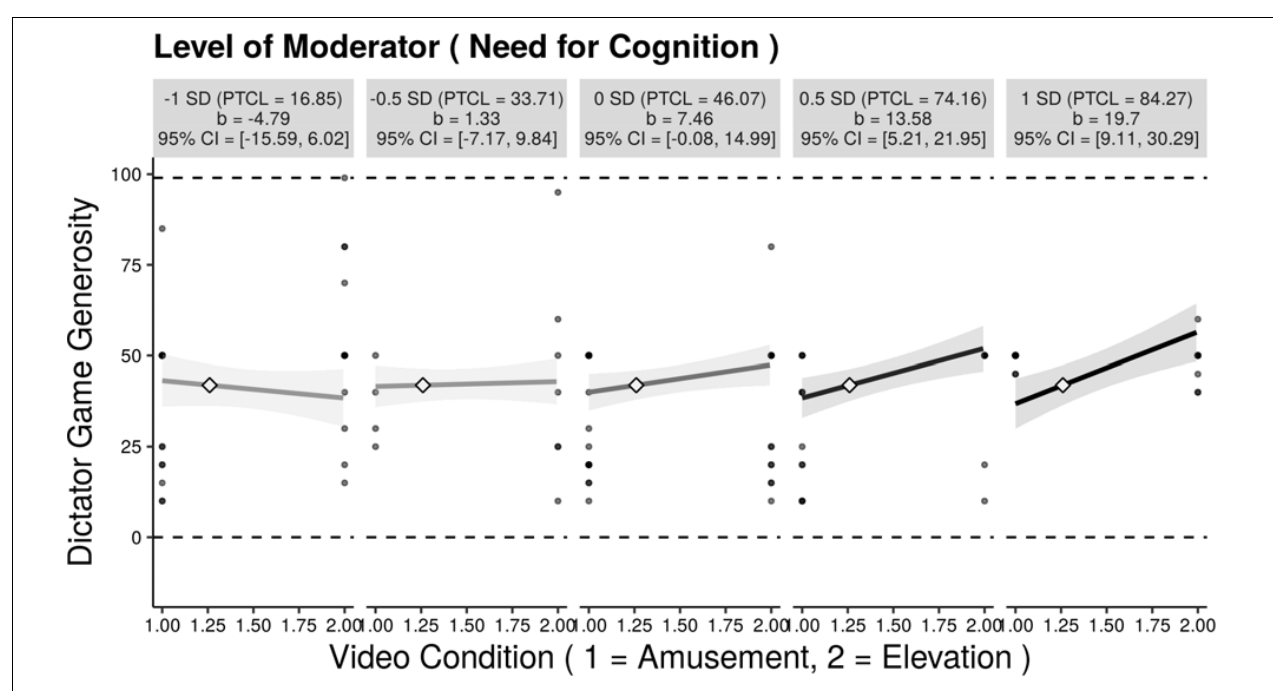
FIGURE 5 | Small-multiples depictions of the interaction effect of video condition and Need for Cognition (the moderator) on dictator game generosity (active cooperation). The small multiples illustrate the interaction across the range from 1 SD below to 1 SD above the mean of Need for Cognition. Each graphic shows the computed 95% confidence region (shaded area), the observed data (gray circles), the maximum and minimum values of the outcome (dashed horizontal lines), and the crossover point (diamond). CI = confidence interval; PTCL = percentile. The results depicted are those using the trimmed sample, N =